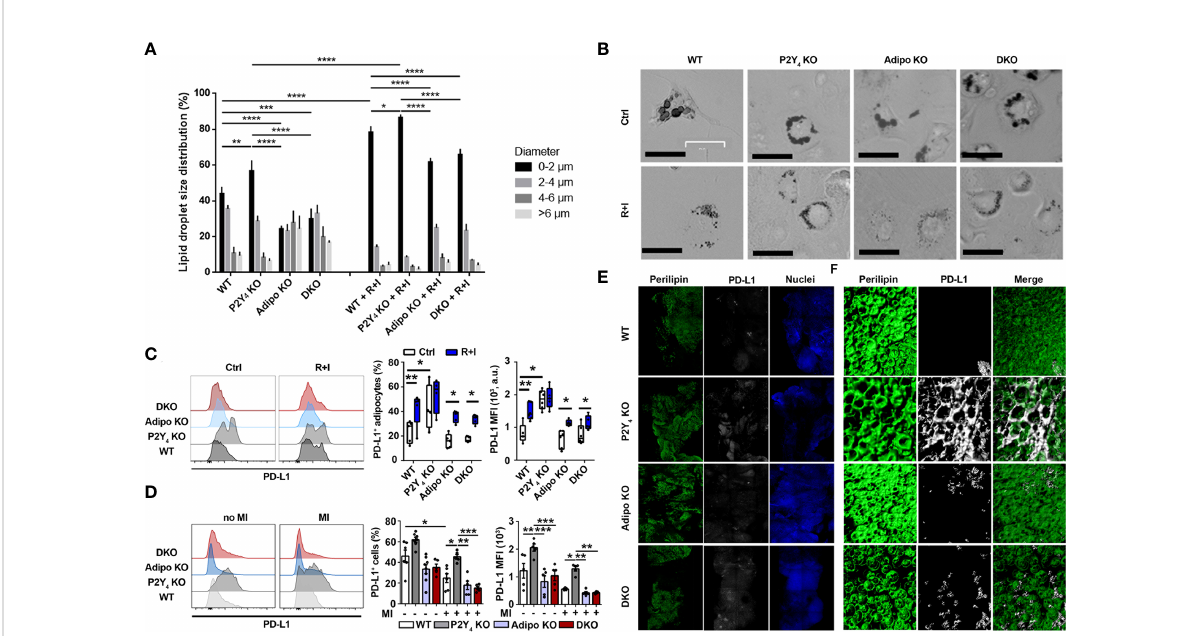
FIGURE 2 Identi fi cation of PD-L1 as a marker of beige adipocytes, upregulated in P2Y 4 KO PAT. (A) Quanti fi cation of lipid droplet size in adipocytes generated from WT, P2Y 4 KO, Adipo KO and DKO cADSCs in the presence or absence of R+I treatment. Quanti fi cation was performed using ImageJ software (n = 4). (B) Oil red O staining of cardiac adipose-derived stem cells (cADSC) cultures after adipogenic differentiation and